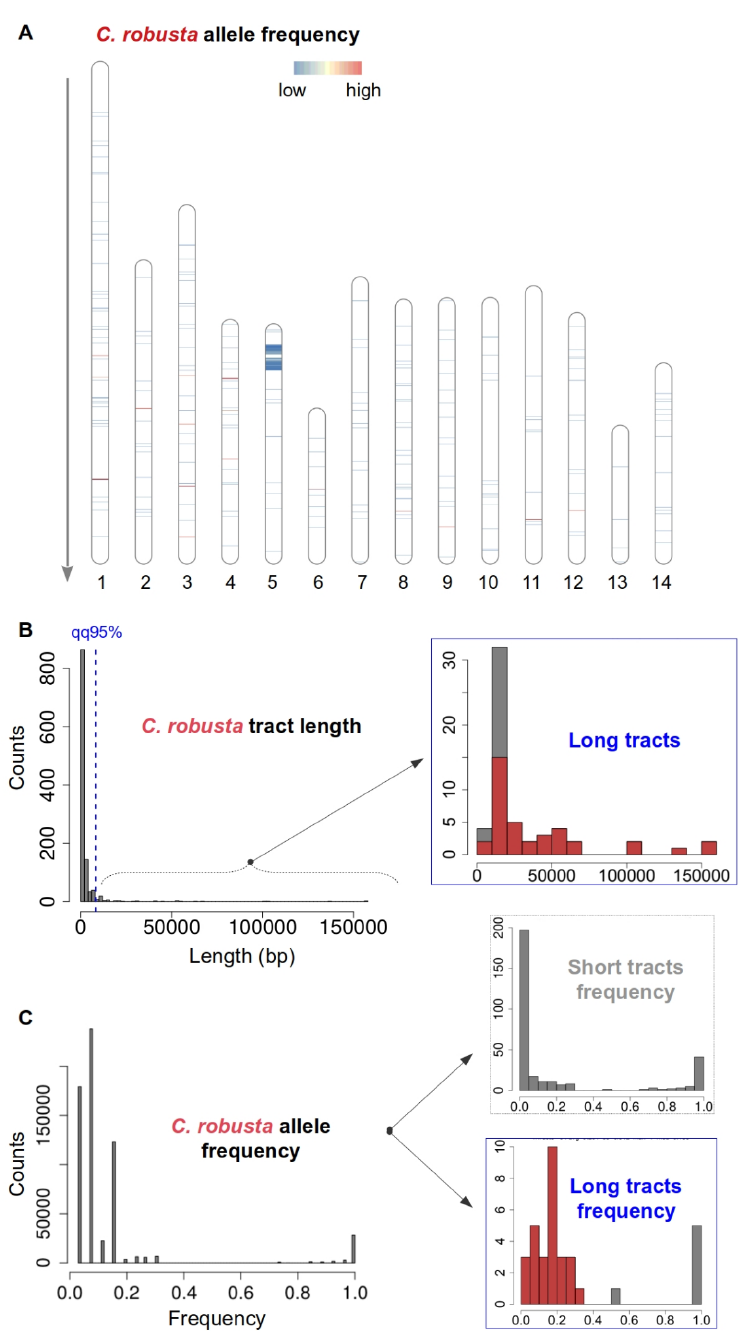
Figure 2: L ocal ancestry patterns of the C. intestinalis genomes sampled using 640,044 phased SNPs.